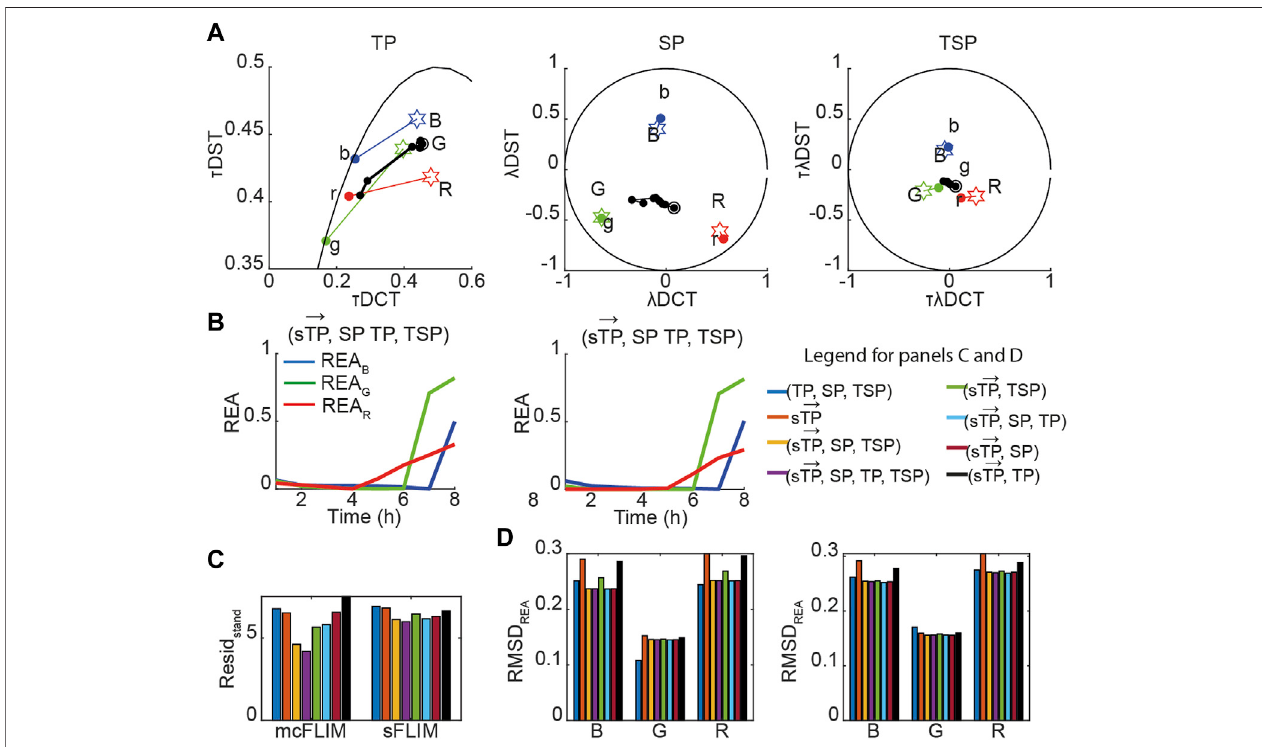
FIGURE 4 | Validation of the demixing algorithms. The experimental data shown in Figures 2 , 3 were summed to generate a synthetic mixed signal (i.e., a cell expressingthree sensors) ofknown ground truth. (A) The mixed signals are shown as different phasor subspaces. The black circles and lines represent the biochemical trajectory of a cell projected on the different phasor spaces. Stars represent the fi ngerprints of the uncleavable sensors (labeled B , G , and R ), and the colored circles the (cid:1)(cid:1)(cid:1) → donor-only fi ngerprints (labeled b , g , and r ). (B) These data were demixed using ( sTP , TP , SP , and TSP ) phasors of sFLIM data (left) and mcFLIM (right) (see also Supplementary Figure S4 ). (C) The standardized phasor residuals summed over time, and (D) REA RMSD for sFLIM (left) and mcFLIM (right)